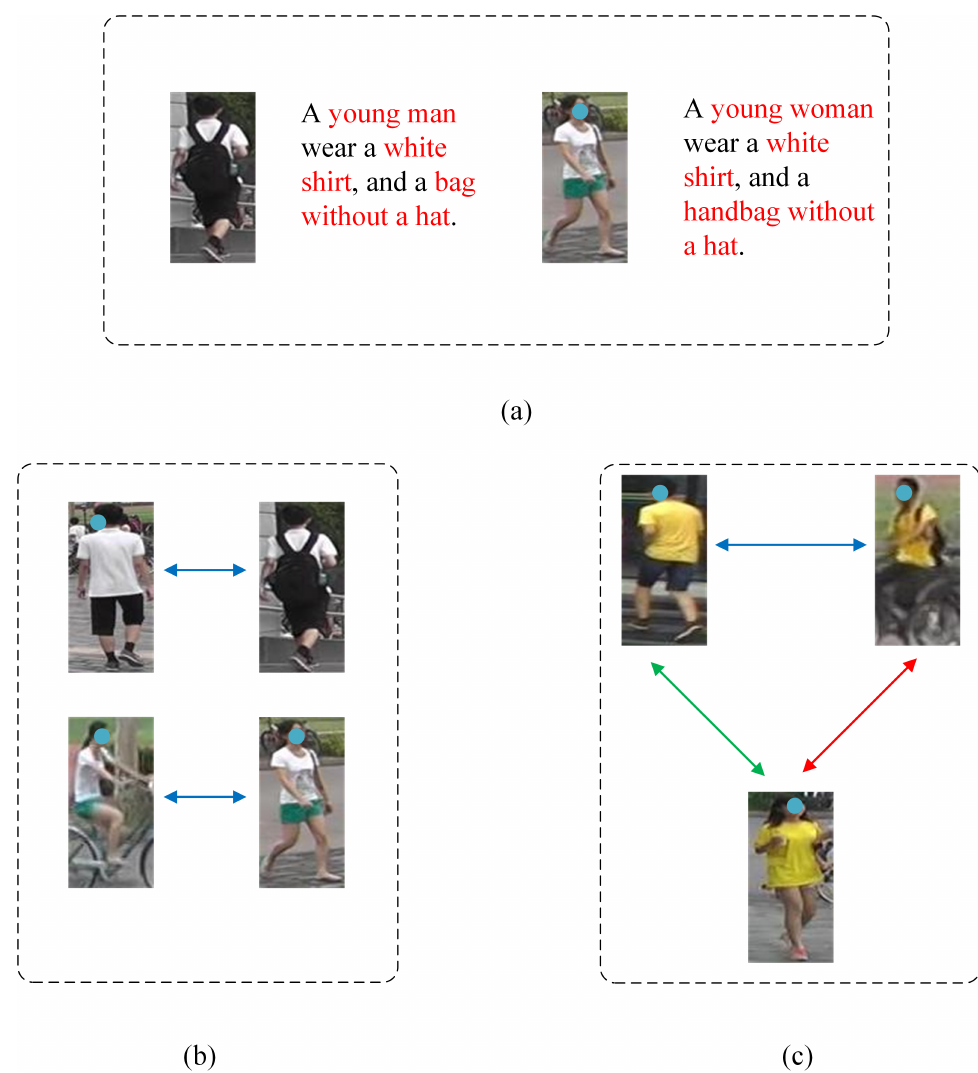
Figure 1. Pedestrian flexibility and rigidity bring challenges to pedestrian re-recognition. ( a ) Learning the semantic information of pedestrian attributes. The red text represents some features of the pedestrian. ( b ) The different states of two different pedestrians. ( c ) The distance between different pedestrians. The double arrows show their distance. Different colors indicate the distance between different pedestrians, and these distances need to be pulled